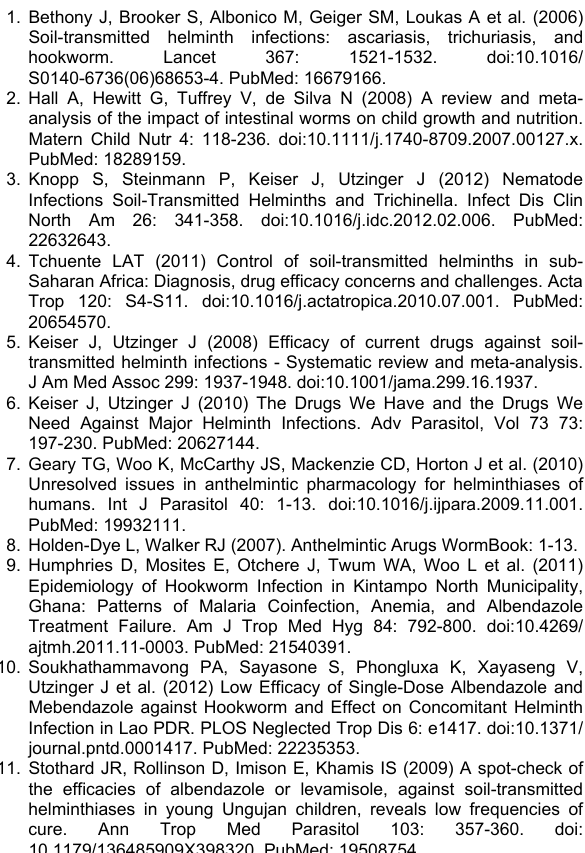
Figure S3. Intoxication of Trichuris muris adults in vitro using five doses of either albendazole (ALB), ivermectin